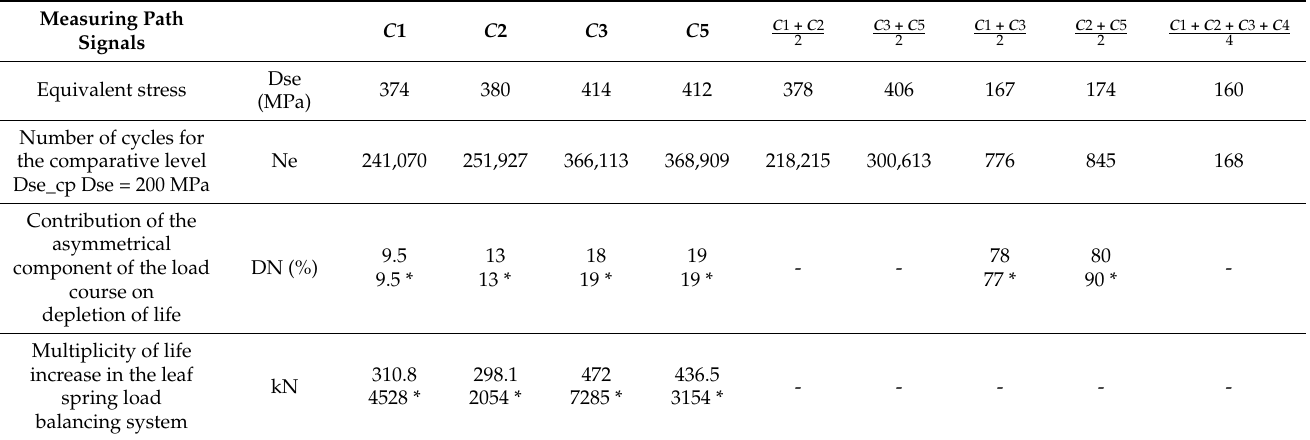
Table 1. Summary of the durability comparison results for material with k * = k =